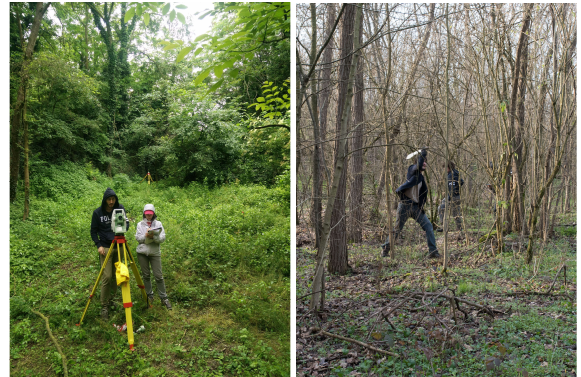
Figure 3. Some phases of the total station survey and the quick cleaning of the path before the backpack walk.